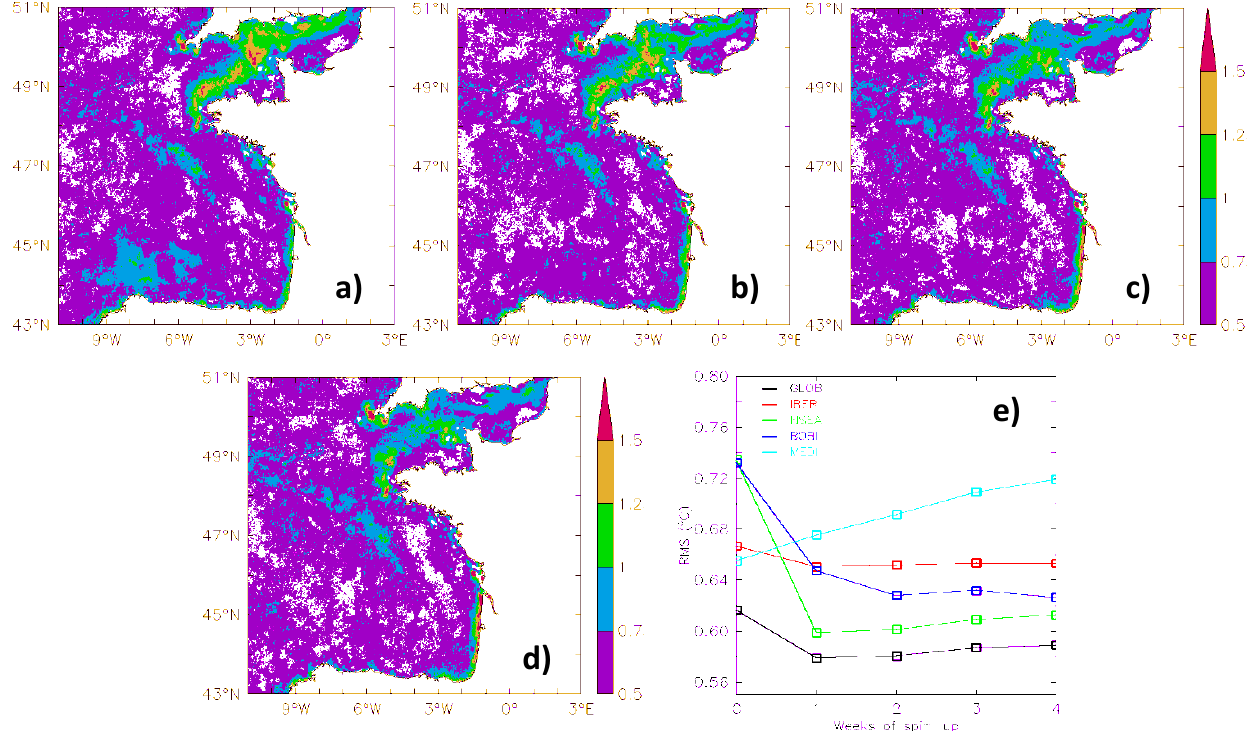
Figure 8 (a), (b), (c) and (d): RMS (observation minus model) Sea Surface Temperature (SST) difference (°C) for the period May-June 2009 for the 1, 2, 3 and 4 weeks spin-up IBI simulations (resp.) , for the Bay of Biscay and Channel region. Figure 8 (e): Spatial average RMS (observation (CMS) minus model) SST difference (°C) for the period May-June 2009 for the 0 to 4 weeks spin-up IBI36 simulations, for the regions GLOB, IBER, NSEA, BOBI and MEDI presented in fig. 7.